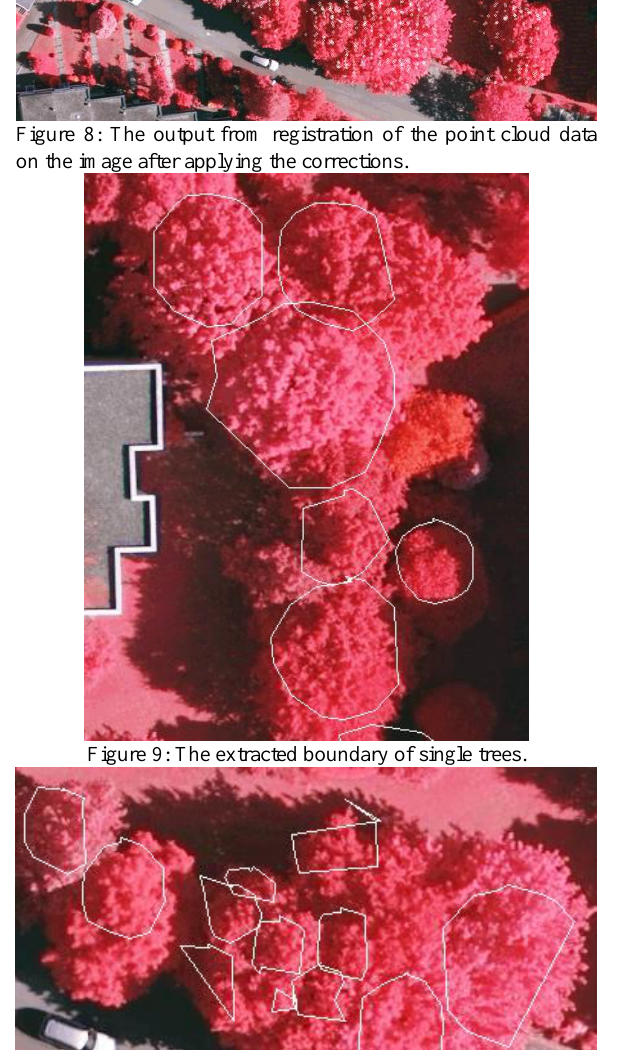
Figure 10: The extracted boundary from a multi trunks tree.